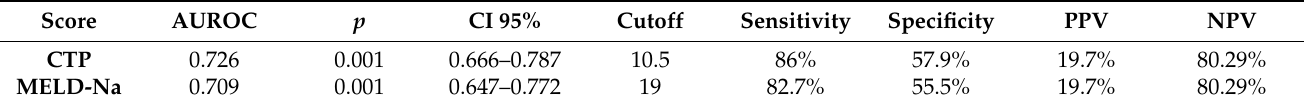
Figure 3. Analysis of the ROC curve for predicting scores (CTP and MELD-Na). CTP: Child–Turcotte–Pugh, MELD-Na: model for end-stage liver disease-sodium. Table 5. Performance of predicting scores (CTP and MELD-Na)—multiple hospitalizations.